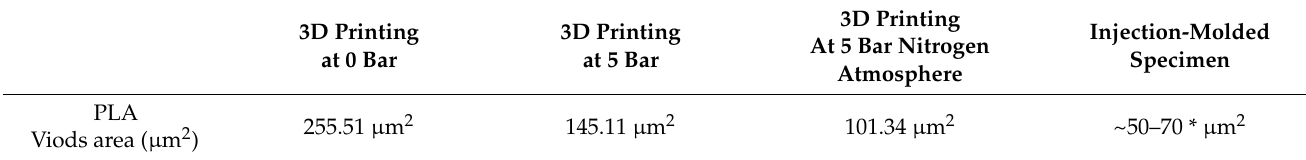
Table 1. Averaged area of voids that were captured during microscopy.